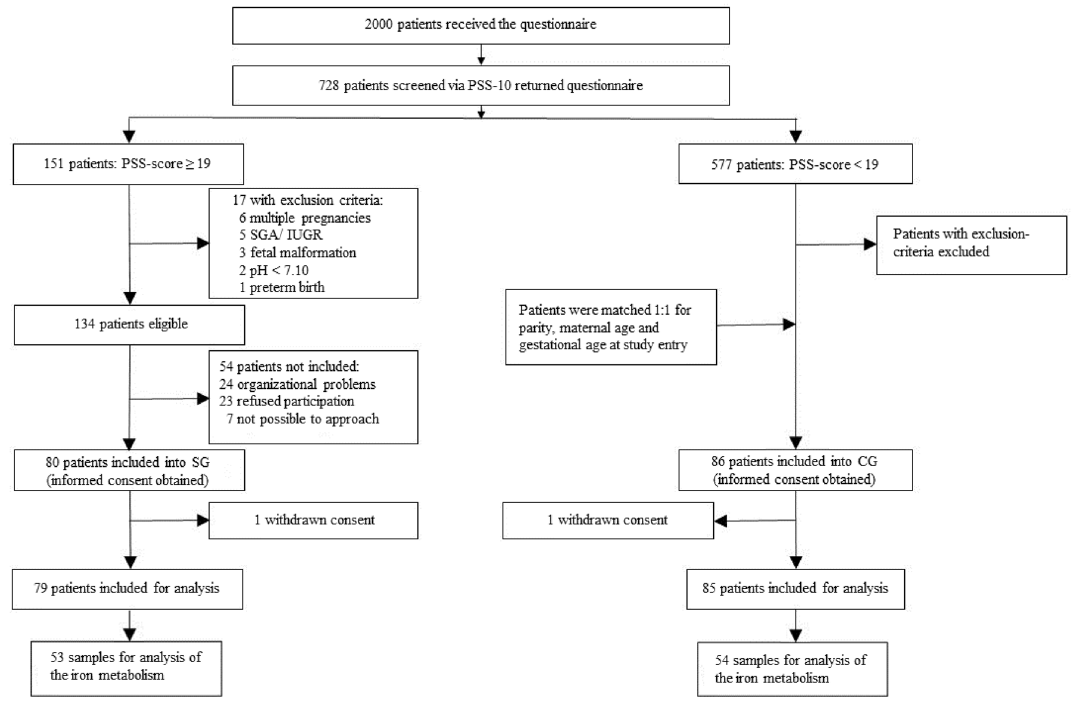
Figure 4. Recruitment flow chart. SG stressed group, CG control group, PSS perceived stress scale, SGA small for gestational age, IUGR intrauterine growth